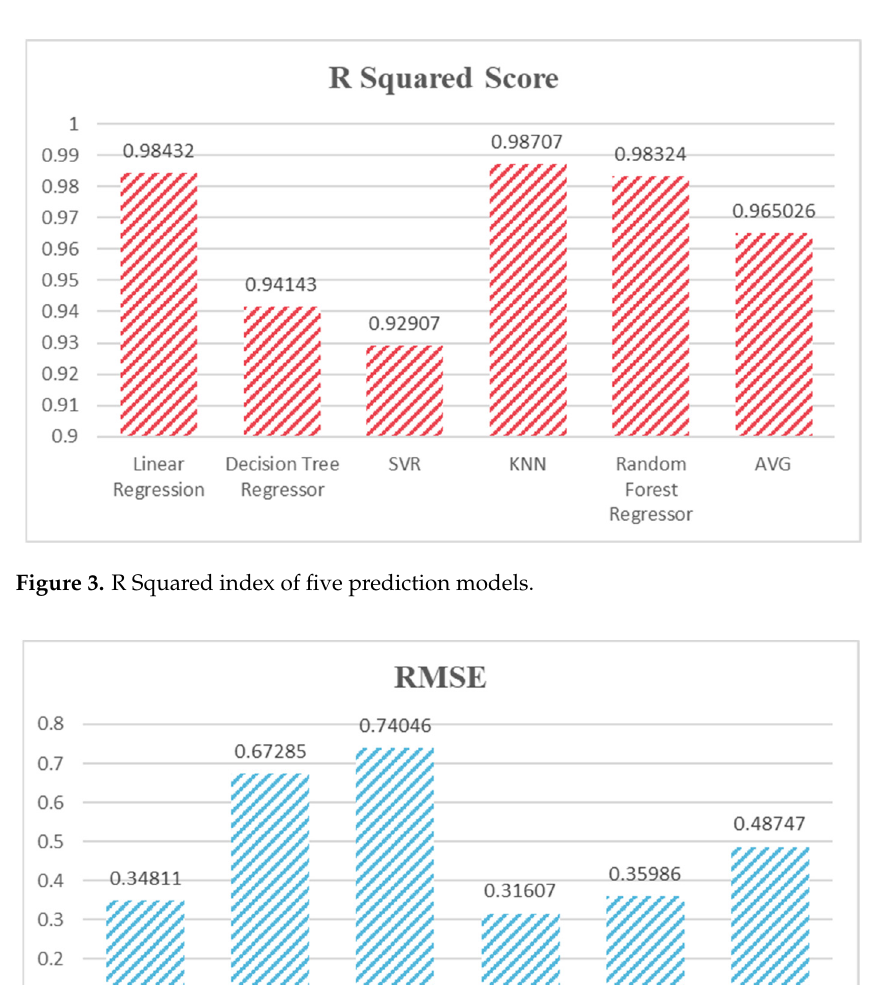
Figure 5. Mean Absolute Percentage Error of five prediction models. Further analysis from Figures 3–5 show that, among the five algorithm prediction models, the experimental group and the control group have a high degree of fit, and the average absolute percentage error is also small, which indicates that the evaluation model designed in this study can effectively assist teachers to evaluate students more accurately. Among them, KNN has the largest R Squared Score, and RMSE and MAPE have the small- est value. According to specific indicators, KNN algorithm has the smallest error in the prediction model, which is closer to the expert rating. Therefore, KNN algorithm has the strongest stability in this system model. Finally, KNN algorithm is deployed in the system. In the later stage, more labeled real data will be added to the evaluator model, and the iterative procedural evaluator model will be constantly updated to make its performance more powerful and its evaluation more accurate. 6. Conclusions and Future Work In the context of the networked era, students are engaged in richer learning, so the evaluation of students should be more multimodal, especially in the field of vocational education. In this paper, we focus on the field of practical training education and build a